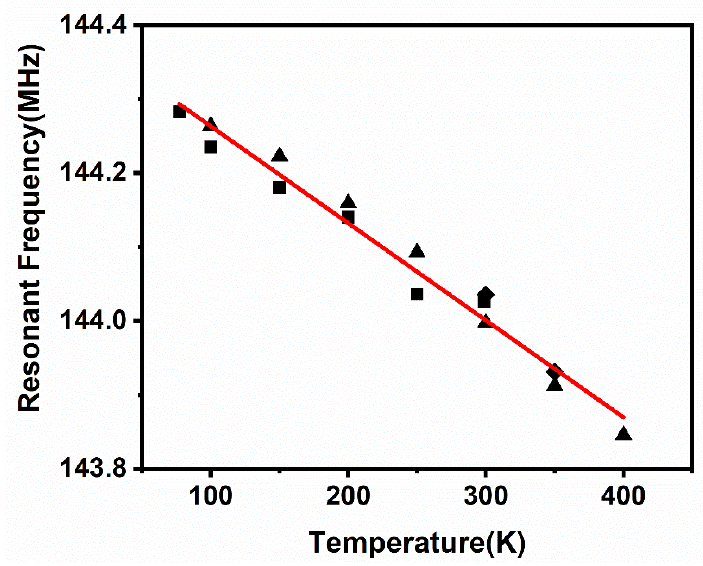
Figure 8. Results of the resonant frequency versus temperature of the resonator.